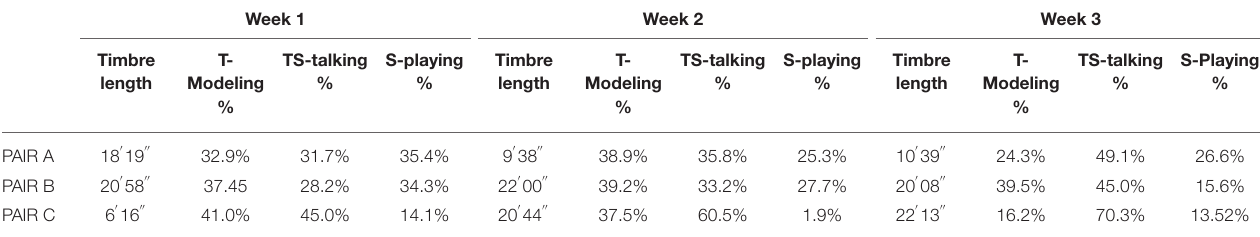
TABLE 2 | The duration spent on the teaching/learning of timbre in a piano lesson across 3 weeks in three pairs and the percentage of time of T-modeling, TS-talking, S-playing in a those piano timbre